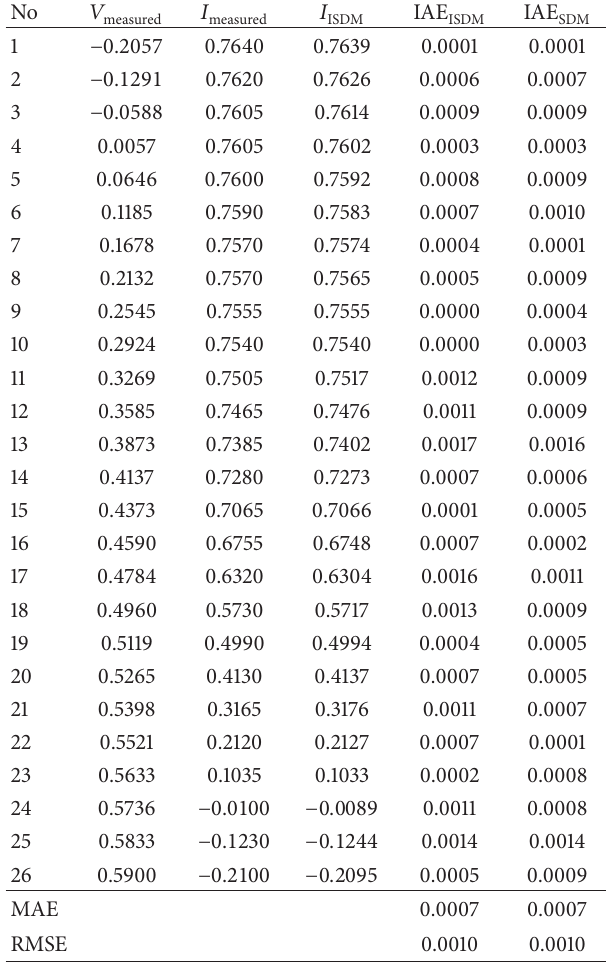
Table 3: A comparison between the errors of ISDM and SDM. The parameters are extracted by the CS algorithm.